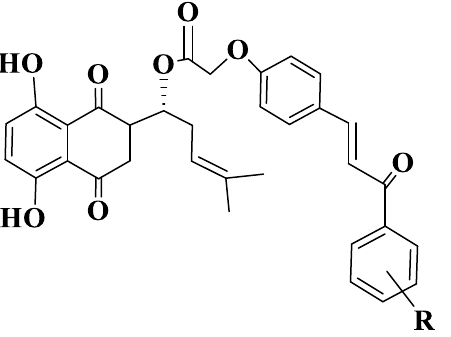
Figure 12. General structure of shikonium-derived chalcones (compounds 215 – 232 ).